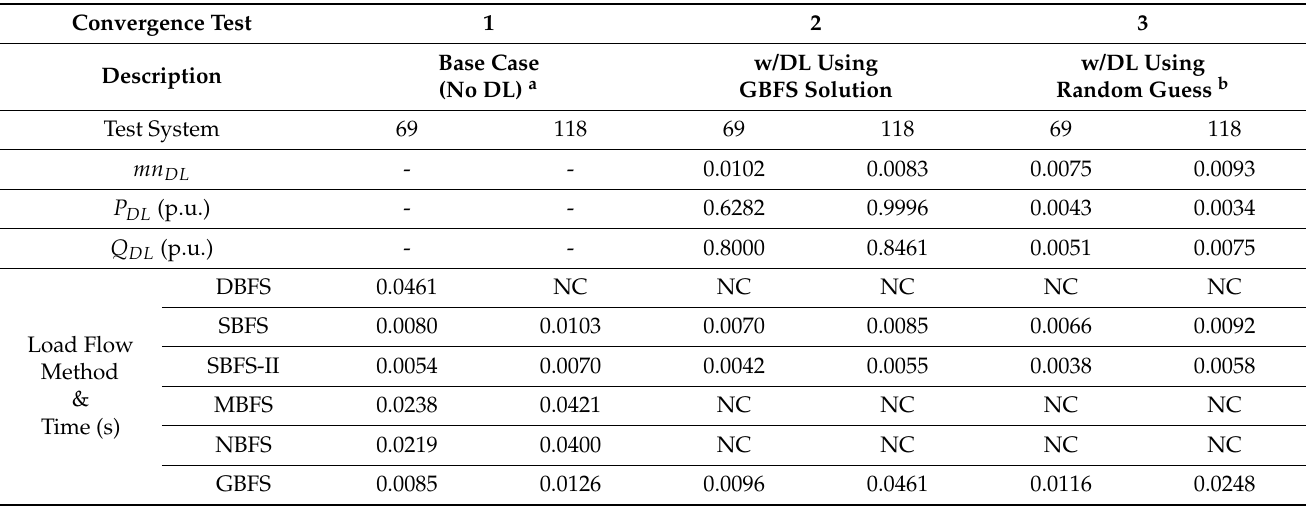
Table 12. Load flow calculation times in seconds for both test systems.